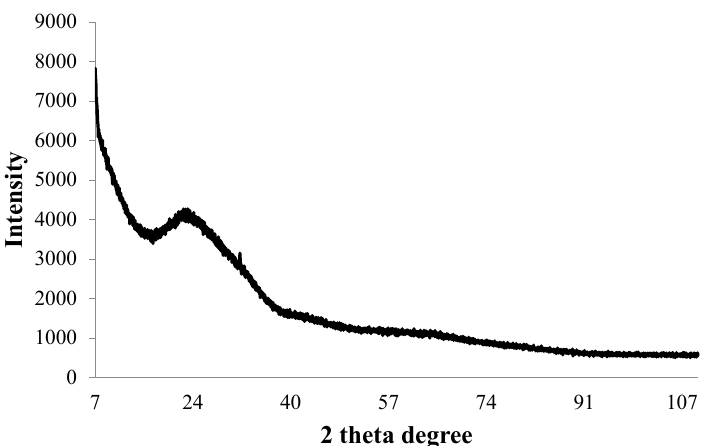
Figure 5. Showing zeta potential value of extracellular IONPs.